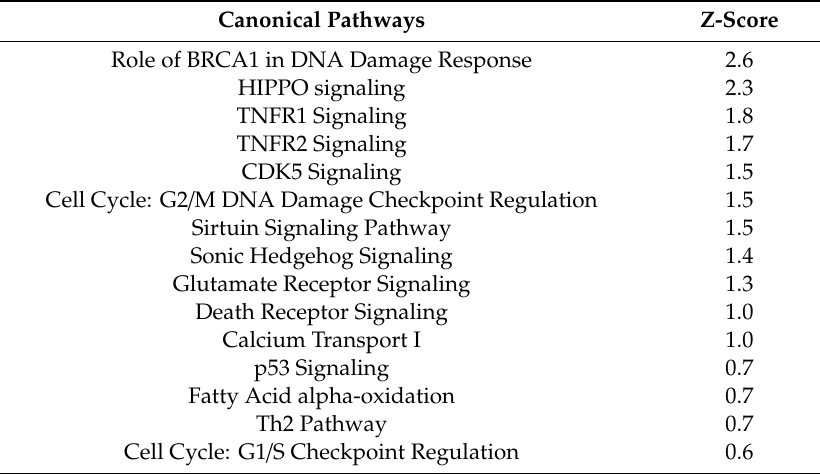
Table 2. Top 15 activated canonical pathways detected in the EBV-high sample by the Ingenuity pathway analysis (ranked by